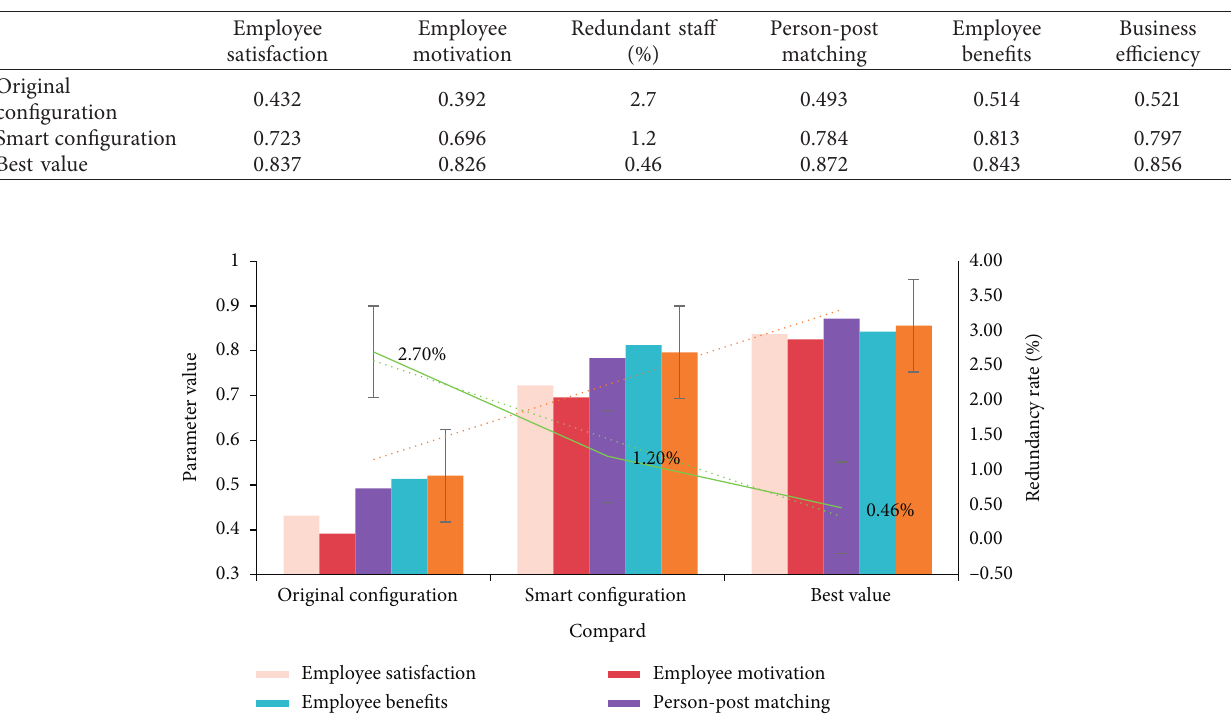
Figure 6: Staff allocation growth. Table 7: Employee satisfaction survey.